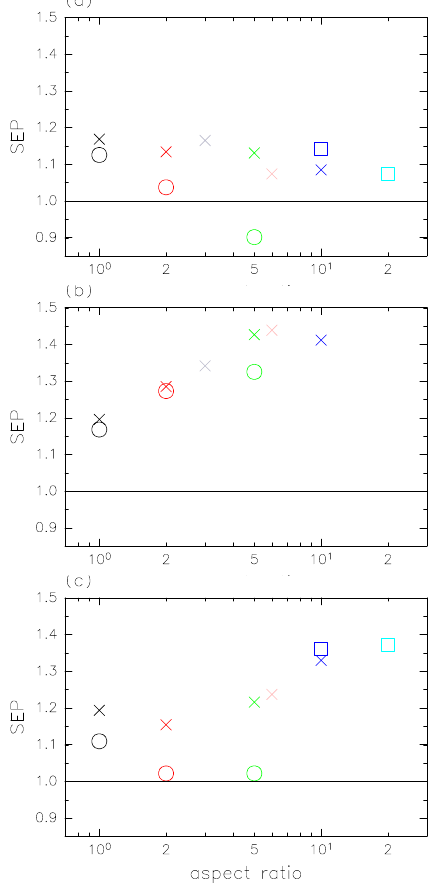
Figure 4. Dependency of the index of energy pile defined in the text on the grid aspect ratio for runs in the (a) control experiment, (b) small filter length experiment, and (c) fixed mixing length ex- periment. Symbol shows vertical resolution; square, cross, and cir- cle shows 5, 10, and 30m, respectively. Colors represent the grid aspect ratio as in Fig.